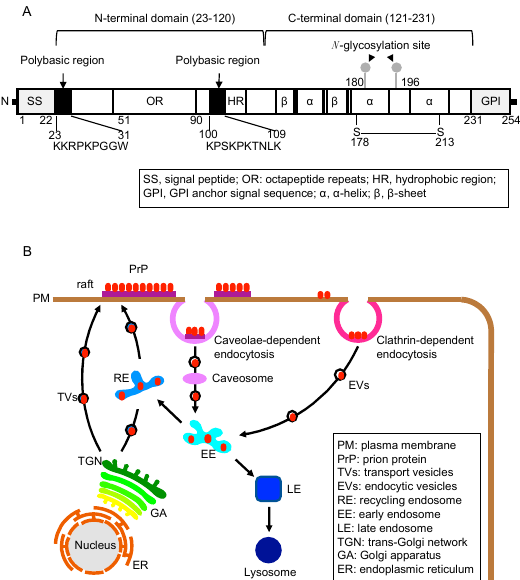
Figure 1. Structure and biosynthesis of PrP C . ( A ) Structural configuration of PrP C . Arabic numbers indicate positions of amino acids. ( B ) Biosynthetic pathways of PrP C , including the vesicle transport pathway from the ER to the plasma membrane, particularly raft domains, and the clathrin- or caveolae-dependent endocytic pathway, which connects to recycling pathway or degradation pathway to lysosomes.